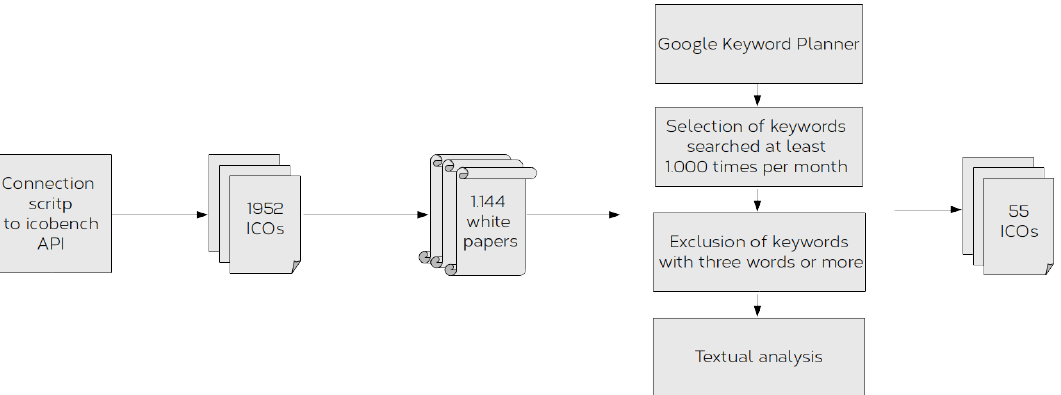
Figure 1. Flow diagram describing the selection process of the Agile